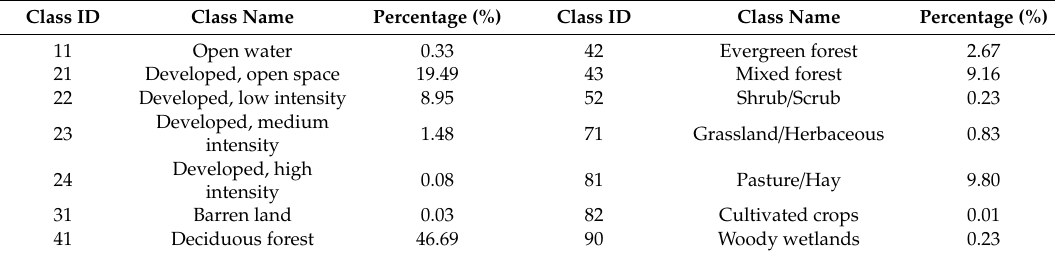
Table 2. Percentage of each land cover class assigned as coarse labels for all the remaining vegetation objects.